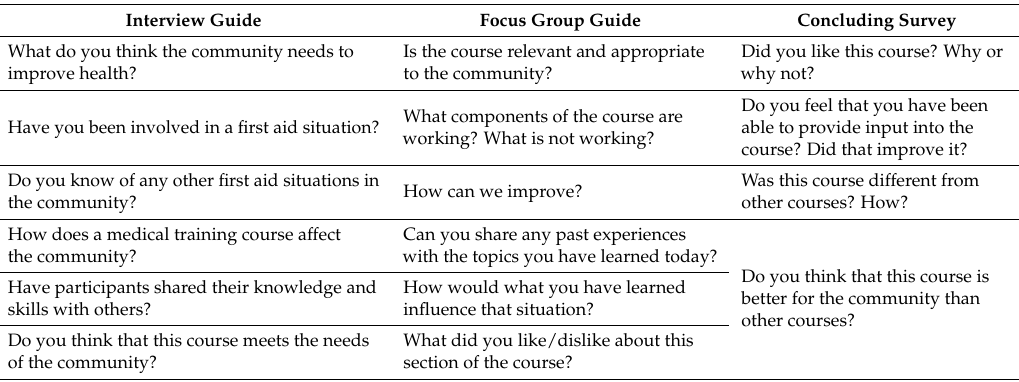
Table 2. Interview and focus group question guides and concluding